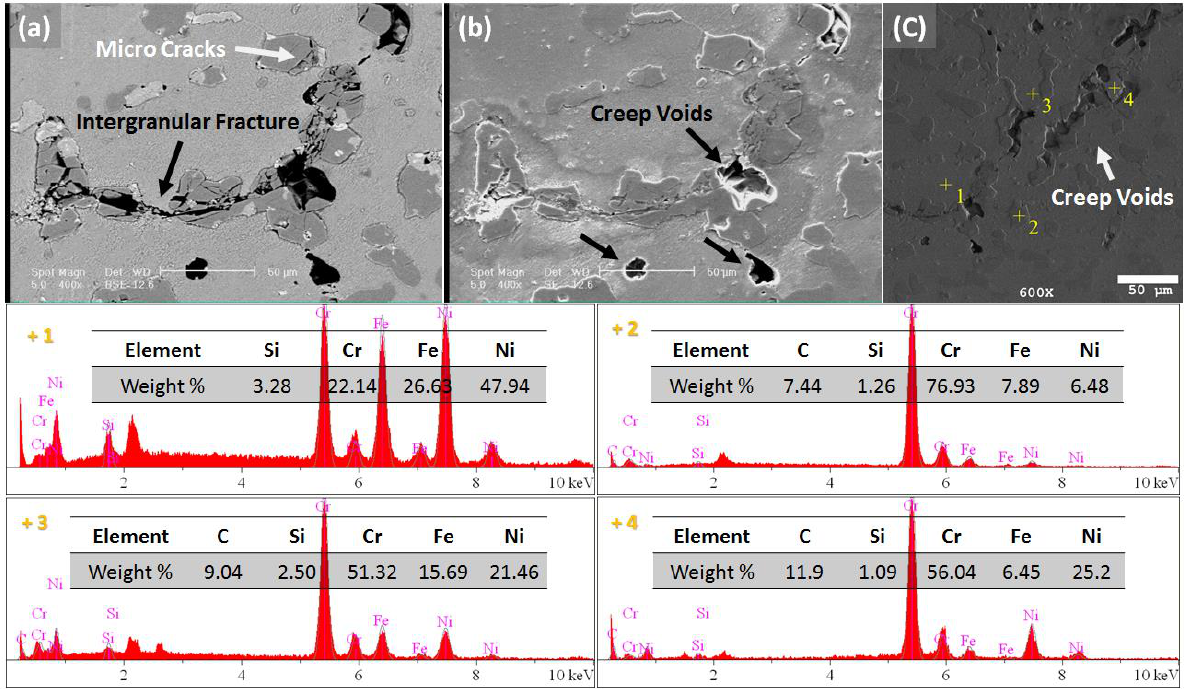
Figure 7. ( a , b ) SEM images of Microstructure degradation of Tube A, ( c ) point analysis of phases in the degraded area using SEM equipped with an EDS. The growth of creep voids and propagation of microcracks at grain boundaries and chromium carbides are shown.